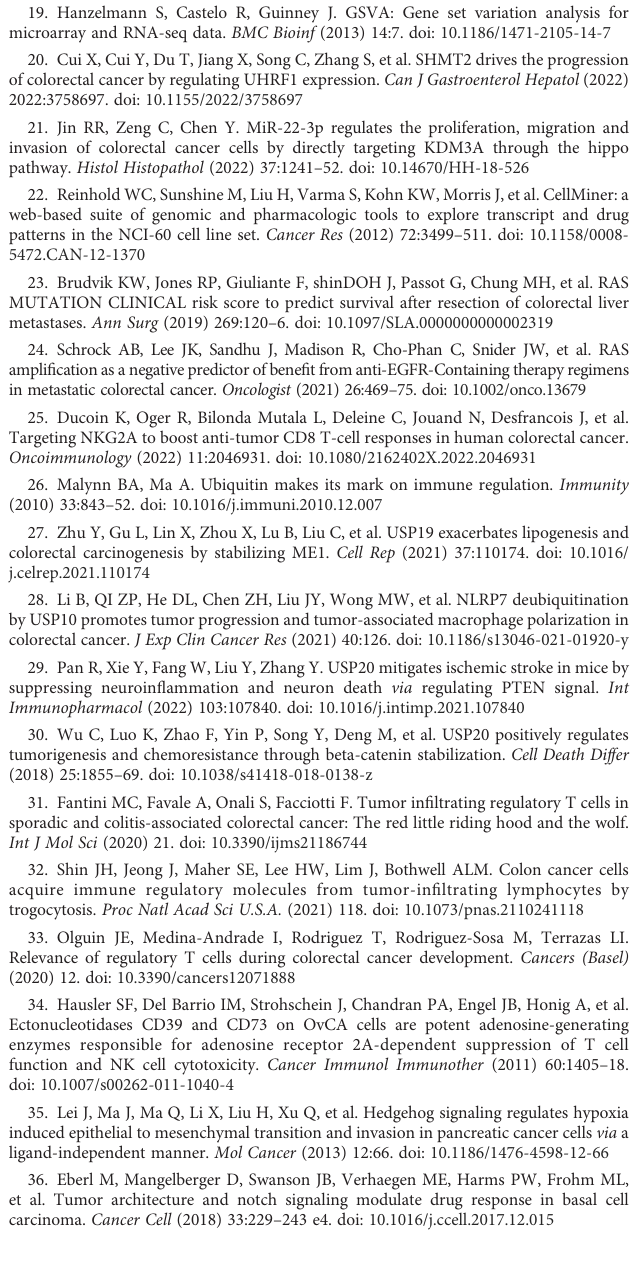
SUPPLEMENTARY FIGURE 1 The USP20 expression in CRC from GEO database (GSE32323); SUPPLEMENTARY FIGURE 2 Gene co-expression correlation analysis of USP20 in colorectal cancer. Twenty cases of fresh colorectal cancer tissues were collected for gene co-expression analysis. (A) . Correlation analysis of USP20 with CD4 T-cell markers. (B) . Correlation analysis of USP20 with the immune checkpoint gene ADORA2A. (C) . Correlation analysis of USP20 with the immune checkpoint gene CD160. (D) . Correlation analysis of USP20 with the immune checkpoint gene CD200. (E) . Correlation analysis of USP20 with the immune checkpoint gene CD27. Correlation was examined by Pearson ’ s correlation analysis. (*P < 0.05; **P < 0.01; ***P < 0.001; ****P < 0.0001; NS, not signi fi